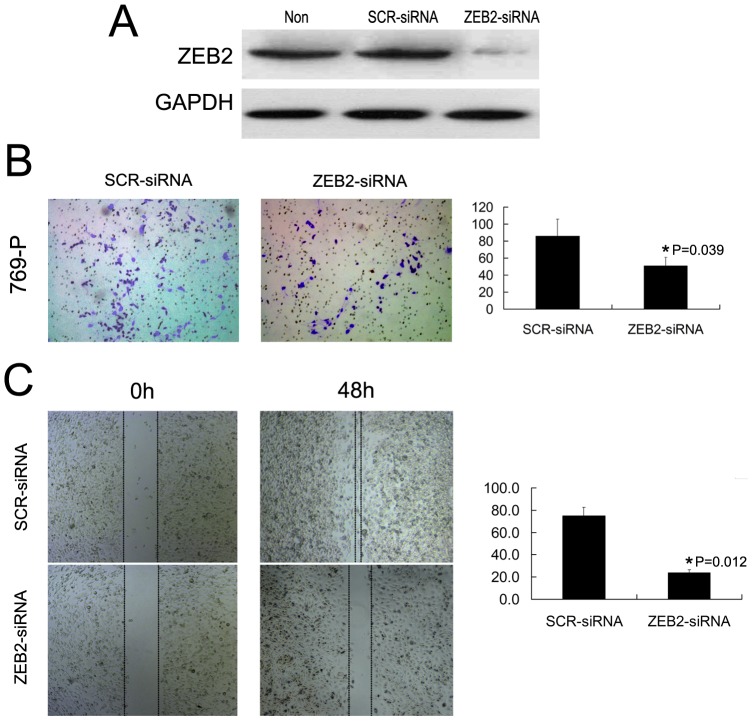
Silencing of ZEB2 by RNA interference inhibits RCC cell migration and invasion.
(A) Western blotting reveals that ZEB2 was efficiently knocked down by the treatment of ZEB2-shRNA. (B) Cell invasion was evaluated using a matrigel invasion chamber. Silencing of ZEB2 decreased 769-P cell invasive capacity. The numbers of invaded cells in siZEB2 and control siSCR groups are shown in the right panel. Error bars indicate ±SE. (C) Wound-healing assays show that ZEB2-silenced 769-P cells had lower motility compared with that in control cells. Data are the means±SE of three independent experiments. *
P<0.05 by unpaired two-sided T-test.